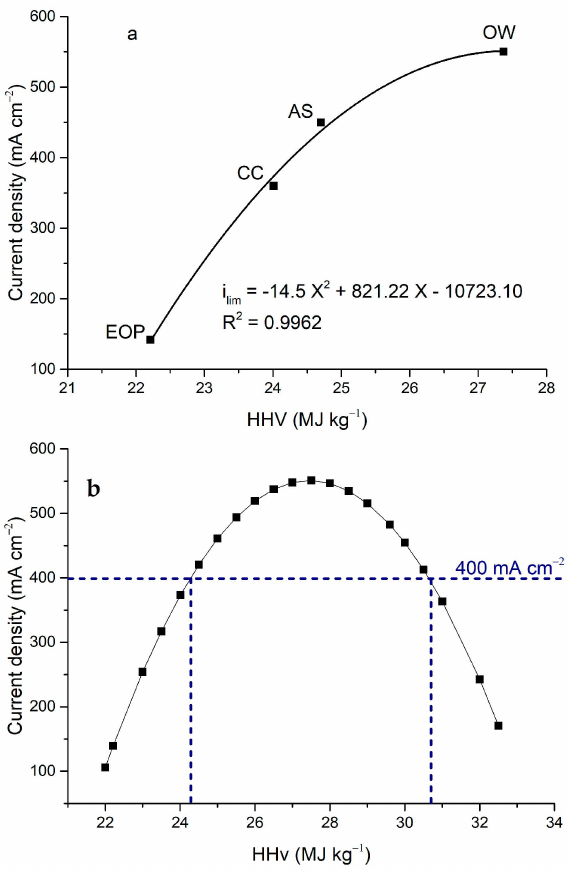
Figure 10. Evolution of ( a ) experimentally recorded current densities and ( b ) modeled polynomial current densities delivered by the DCFC system as a function of the biochar’s